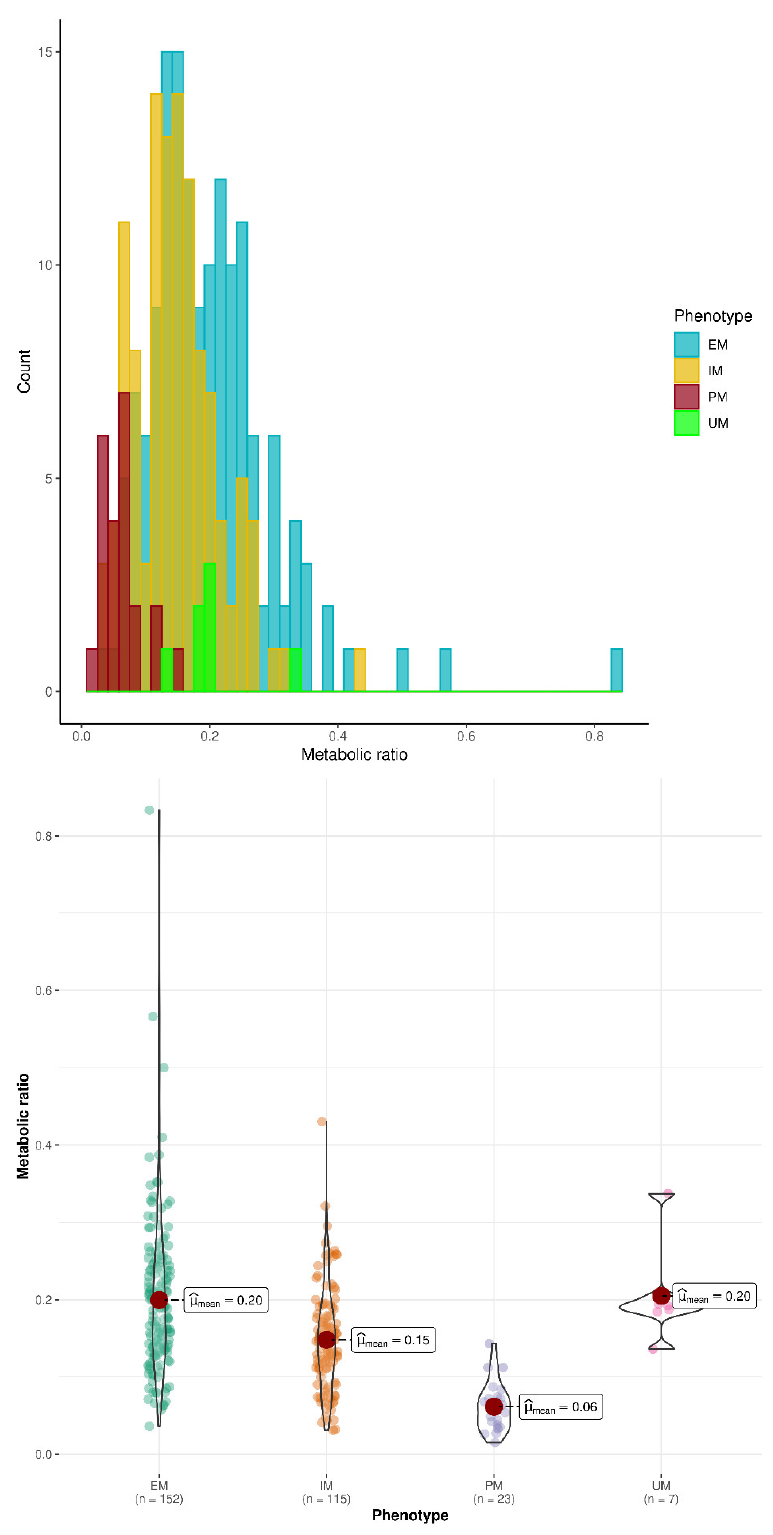
Figure 3. Distribution of O-dT/T ratio at 24 h in all phenotype groups. Upper panel, histogram of phenotype counts; lower panel, violin plot of metabolic (O-dT/T) ratios. The colored dots represent individual data, the large red filled circle represents the mean value, the black solid line shows the probability density of data.